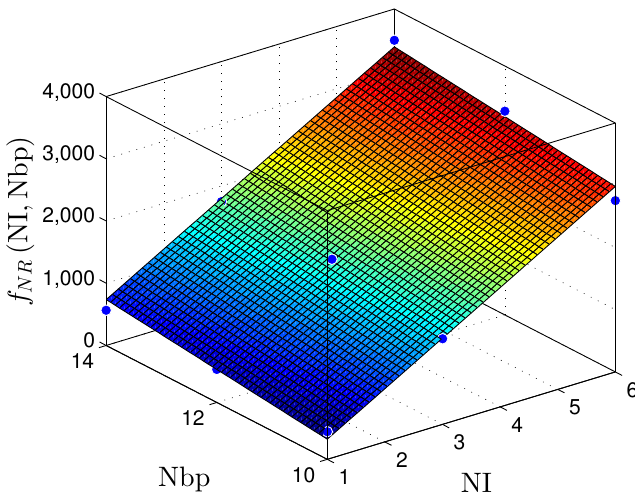
Figure 20. Plane, f NR ( NI , W ) , found to estimate the number of registers, NR, as a function of the number of implementations, NI, and the number of bits in fractional part W for RLMP-based prediction